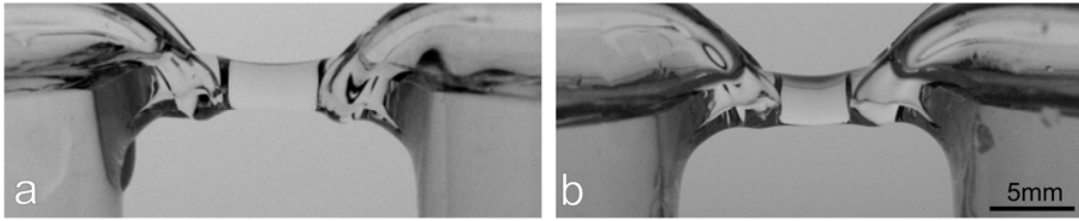
Figure 4. Comparison between a water (a) (9 kV) and a methanol (b) (12 kV) bridge [158].